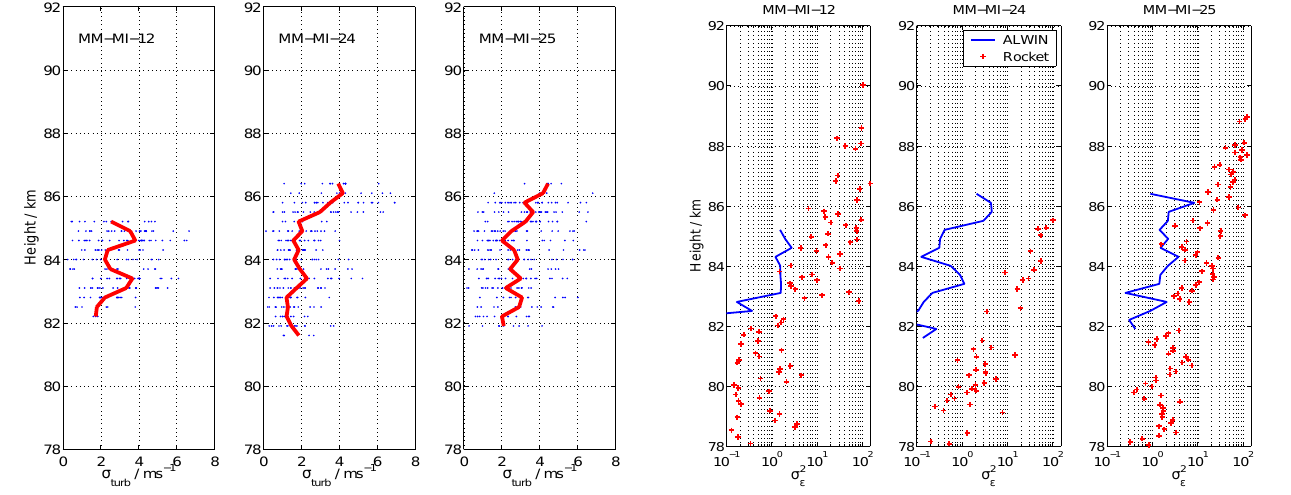
Fig. 8. Turbulent spectral width (individual values and median pro- files) after applying the beam and shear broadening correction.